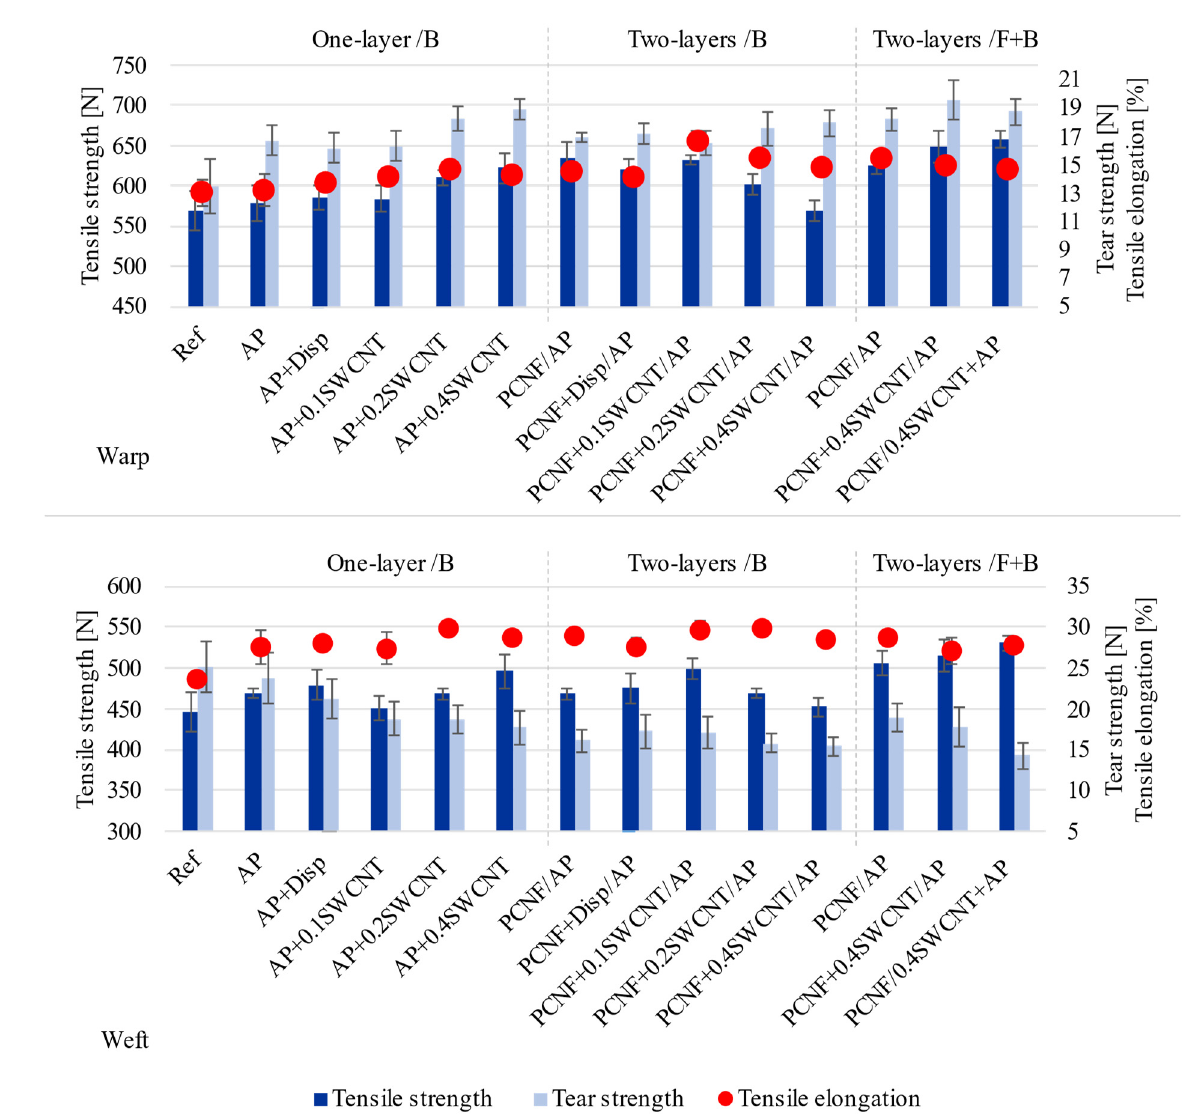
Figure 9. The effect of printing on the fabric’s tensile and tear strength, and elongation, measured in the warp ( a ) and weft ( b ) directions.